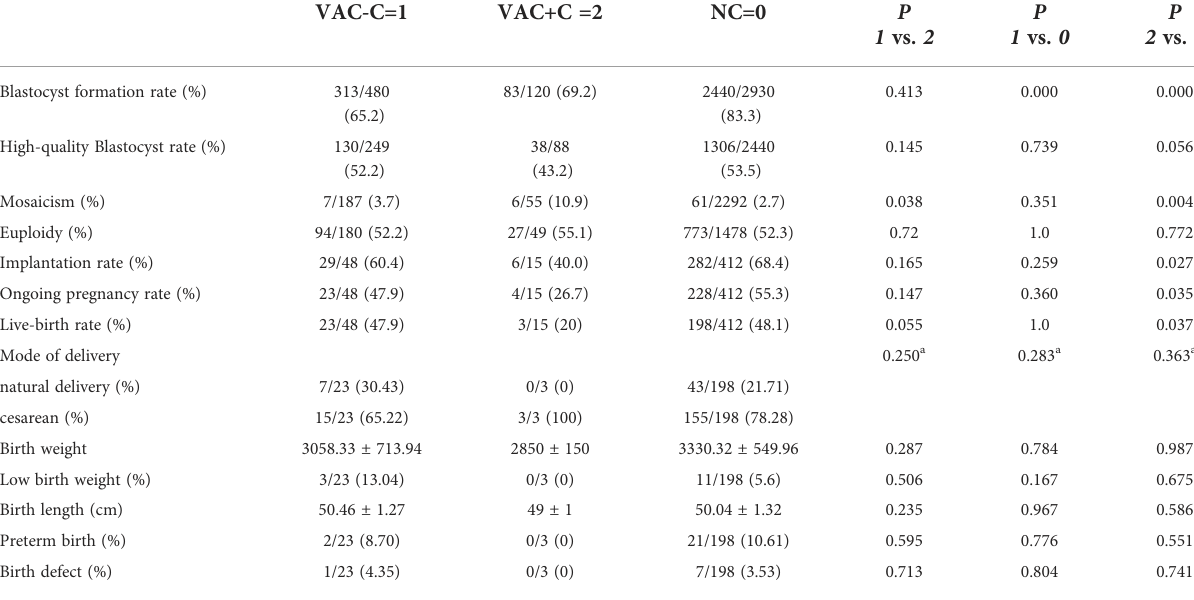
TABLE 4 Embryological and clinical outcomes in VAC+C, VAC-C, and NC